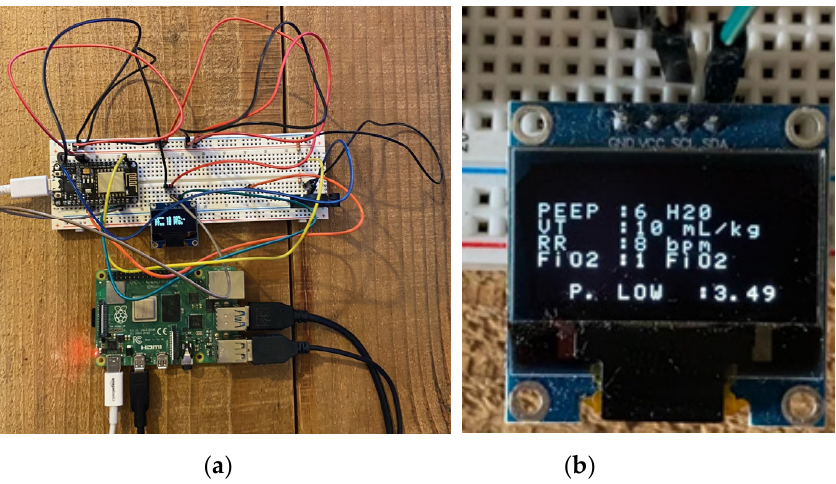
Figure 7. ( a ) NodeMCU ventilator implementation and Raspberry Pi, ( b ) value inserted on dashboard updated on NodeMCU.